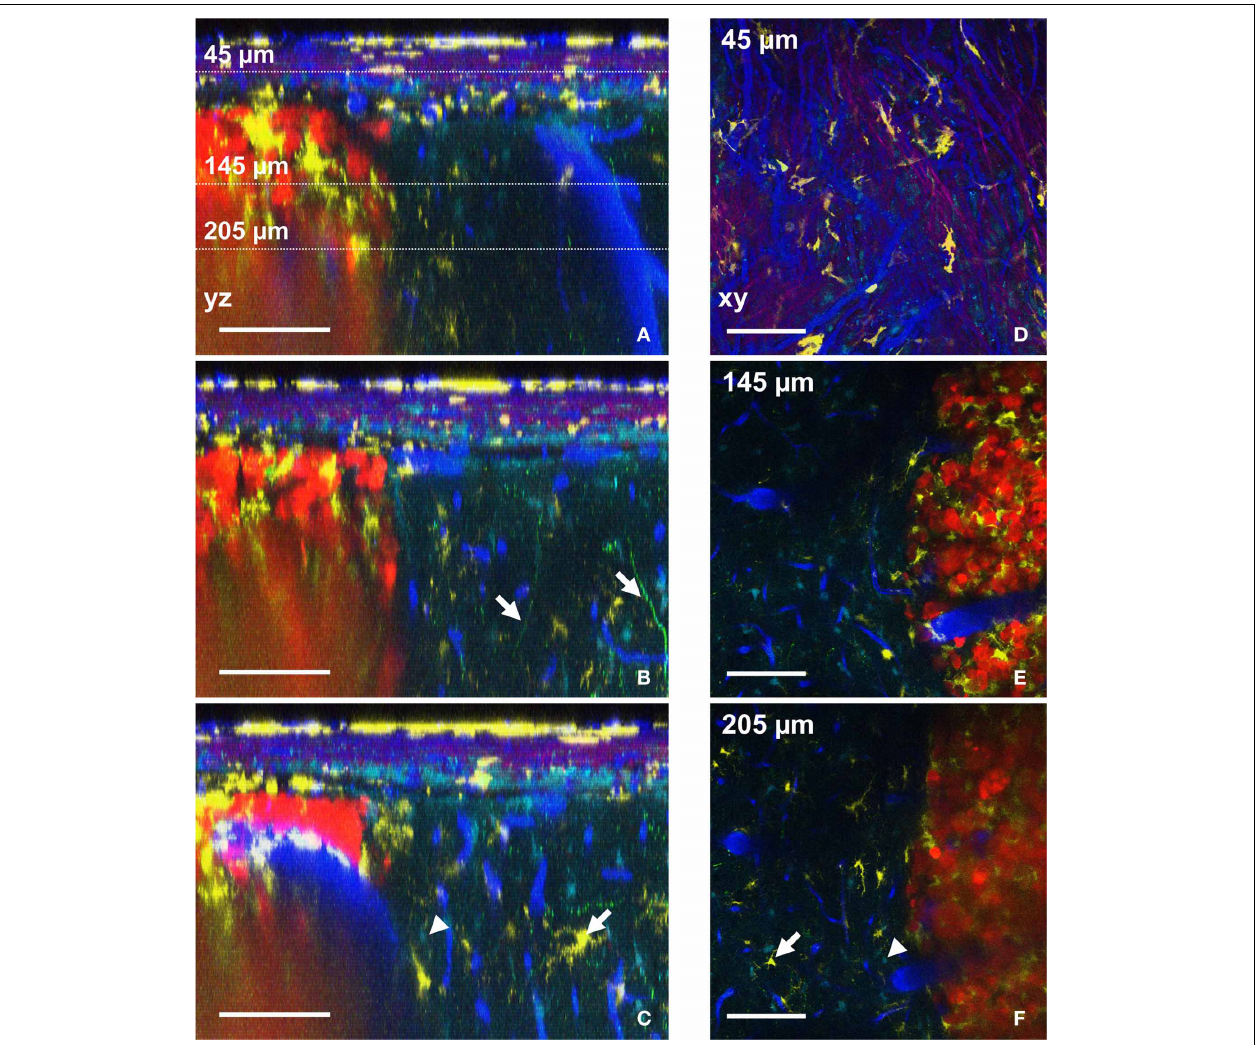
FIGURE 4 | Distributions of six components assessed by intravital two-photon imaging. (A–C) Orthogonal reconstructions obtained from a stack acquired from 0 to 300 μ m below the glass coverslip with a z-step of 3 μ m. Each YZ image shows the maximum intensity projection over 10 microns along the X axis. (A) Note the vertical orientation of major brain vessels; dotted lines: the levels of xy-sections are shown in D–F . (B) Apical dendrites of neurons are visible (arrows). (C) Astrocyte (arrowhead) and CD11c-positive cell (arrow) also visible in